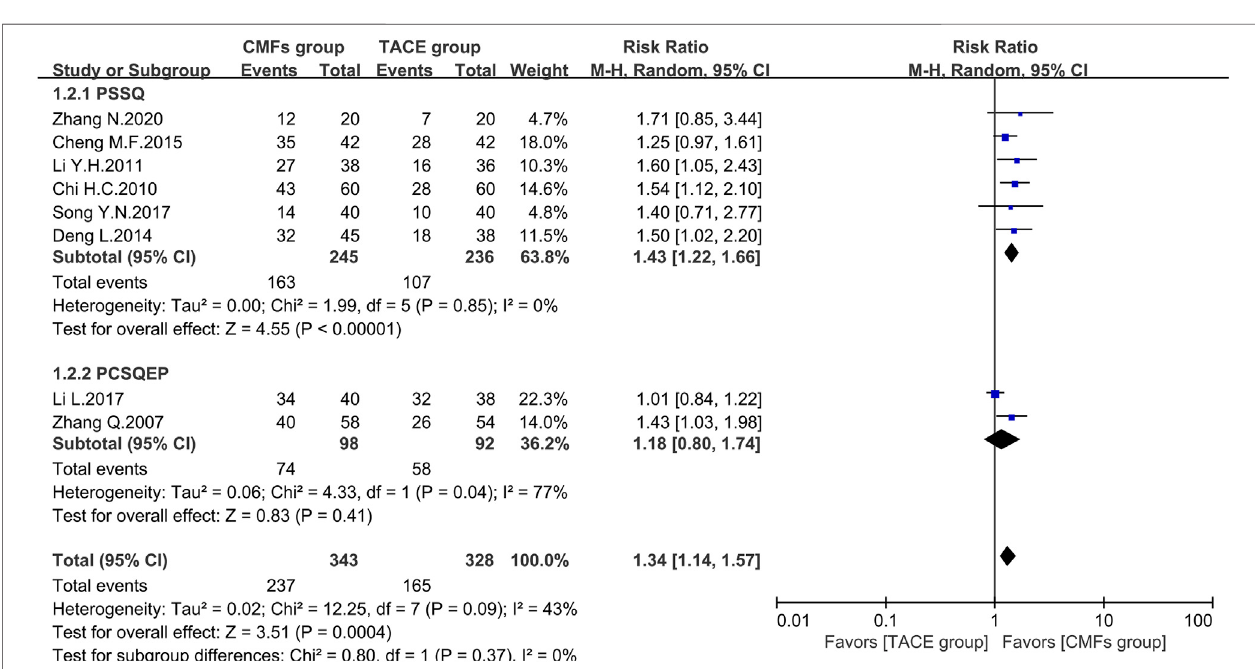
FIGURE 3 | Effect of CMFs group versus TACE group on 1-year survival, including a comparison between PSSQ and PCSQEP in the subgroup.